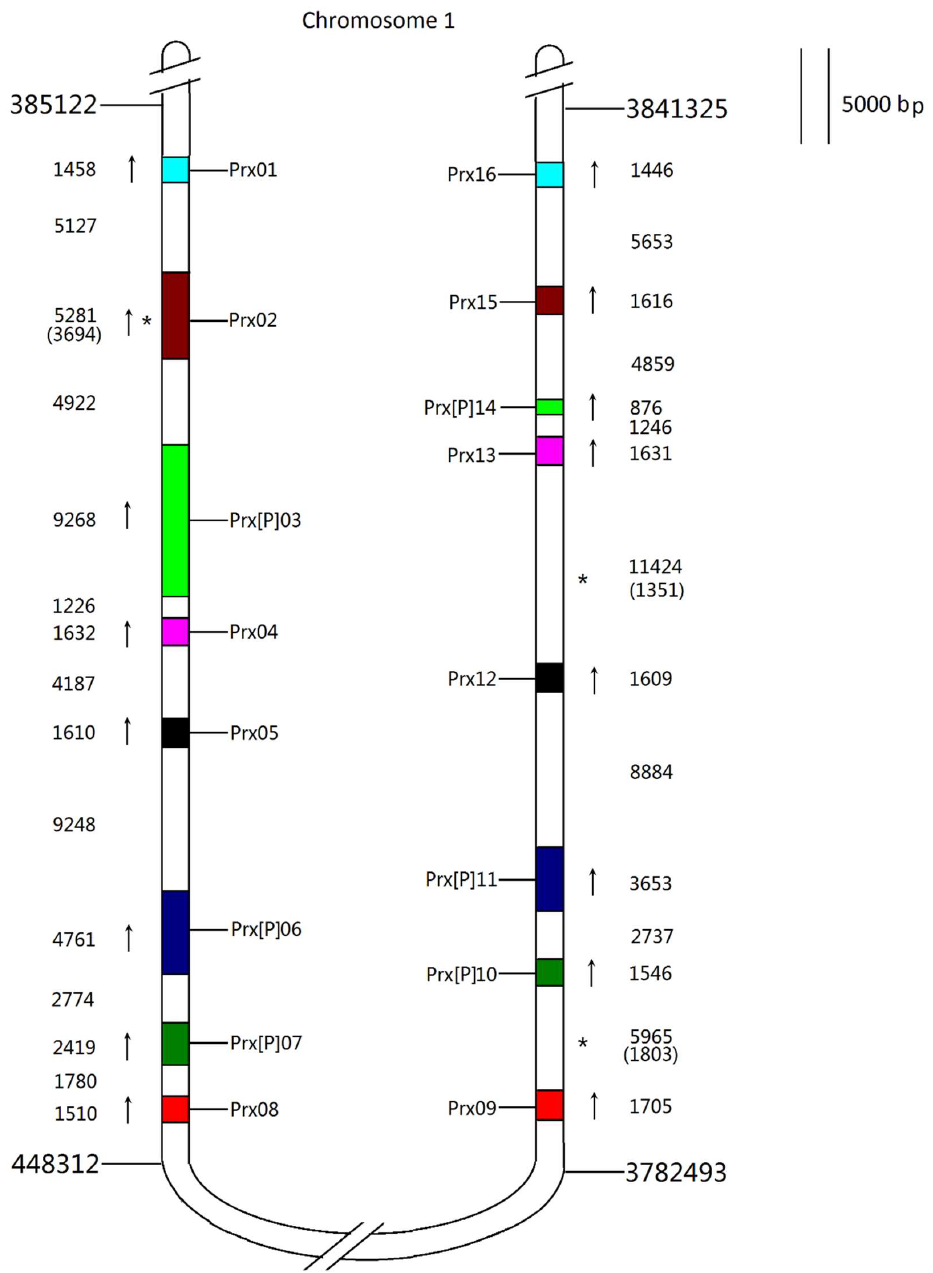
Figure 4. A large duplicated CIII Prx gene cluster on chromosome 1. The sizes of genes and segments are to scale. The start and stop positions of the duplicated segments were written on the top and the bottom of the segments. The colorful regions represent the CIII Prxs in the segments on chromosome 1 and the gene orientations were shown with the arrows on the left or right. The sizes of genes and intervals are noted on the side of each sequence with the numbers of undetermined nucleotide acids in brackets. The homologous genes were displayed with the same color on the two duplicated segments. [P]: the gene has been annotated as pseudogene. *: there are undetermined nucleotide acids (NNN…) in the DNA sequences. The visualization of the chromosomal localization was built by Mapchart 2.1. Arrows represent the gene orientations on chromosomes.